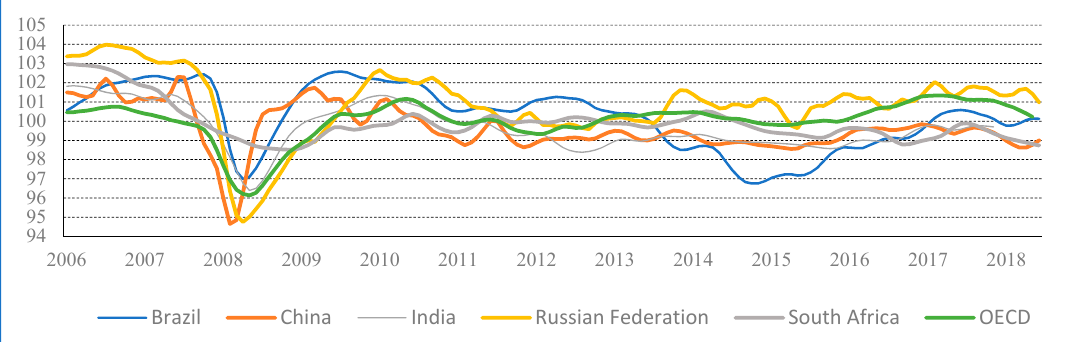
Figure 5. Investor confidence index. Source: Own elaboration based on World Development Indicators (World Bank).